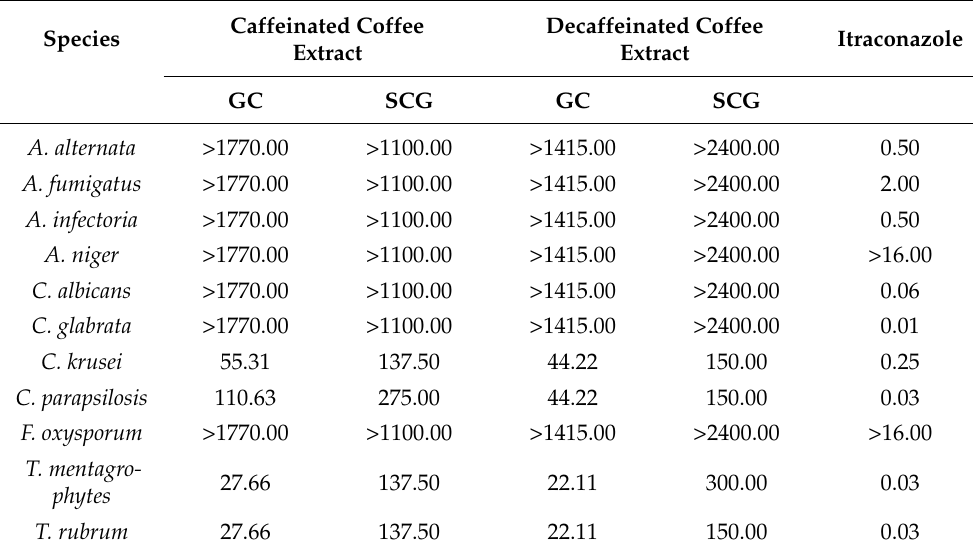
Table 2. Minimum inhibitory concentration (MIC) of caffeinated and decaffeinated extracts and itraconazole for different species (ug/mL). Three independent experiments were performed. Caffeinated Coffee Decaffeinated Coffee Itraconazole Species Extract Extract GC SCG GC SCG